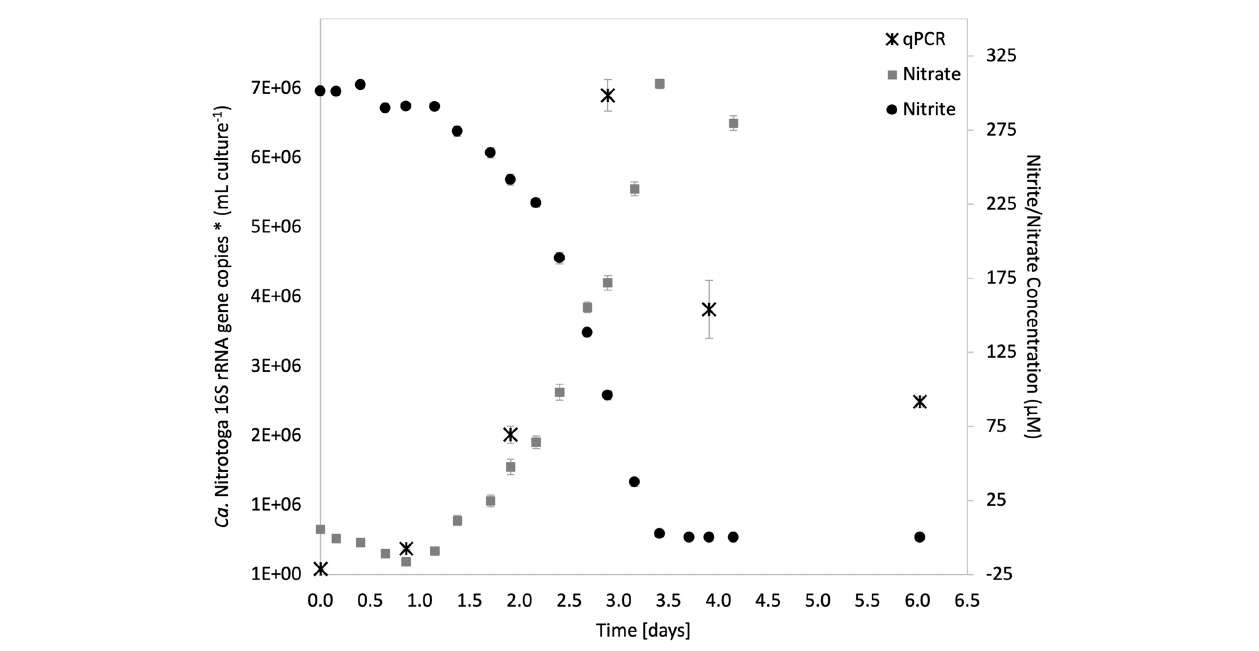
FIGURE 1 | Nitrite oxidation in the Ca . Nitrotoga sp. CP45 enrichment culture coupled with increased concentrations of nitrate and copies of Ca. Nitrotoga 16S rRNA genes. Nitrite (black circles) and nitrate (gray squares) values are averages of quadruplicate vials (each with duplicate sample measurements) at each sampling time point with error bars representing ± the standard error of the mean (SEM). Gene copy numbers measured by qPCR (black stars) are averages ± SEM error bars across three technical replicates. If not visible, error bars are smaller than data